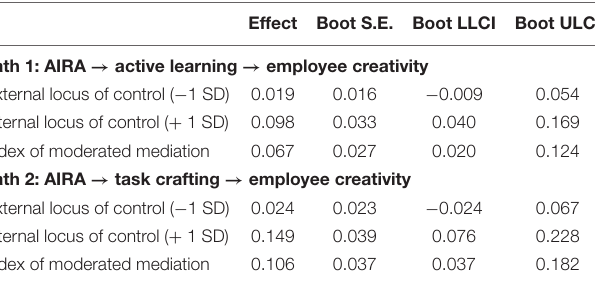
TABLE 8 | Results of moderated mediating effect